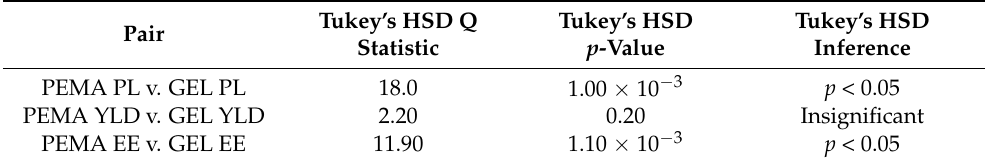
Figure 3. The payload (PL), yield (YLD) and encapsulation efficiency (EE) for the microcapsules formulated with PEMA and GEL as emulsifiers. Table 1. Tukey’s statistical analysis for the measurement pairs, for the PEMA and GEL PL, YLD and EE respectfully.